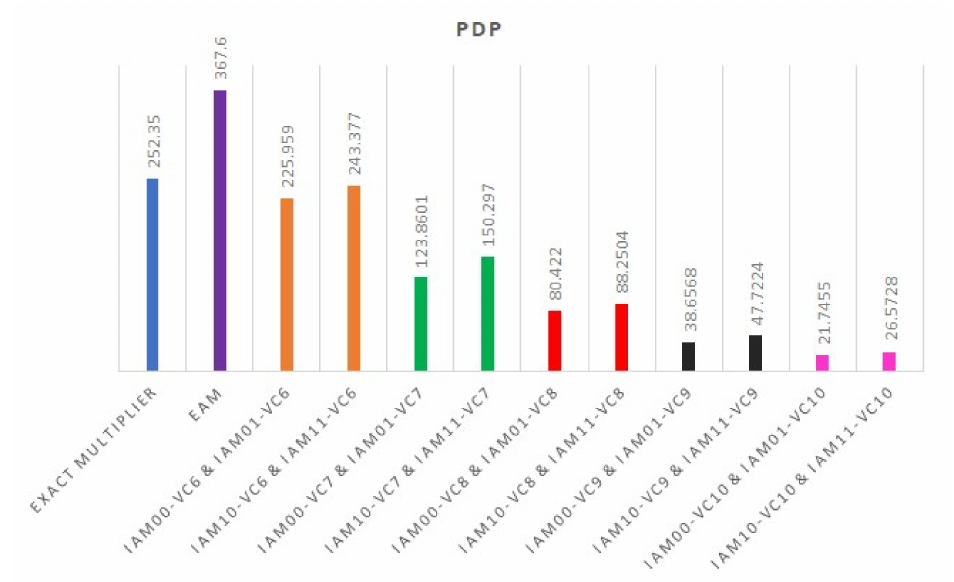
Figure 8. Power-delay product (PDP) of exact and inexact 8 × 8